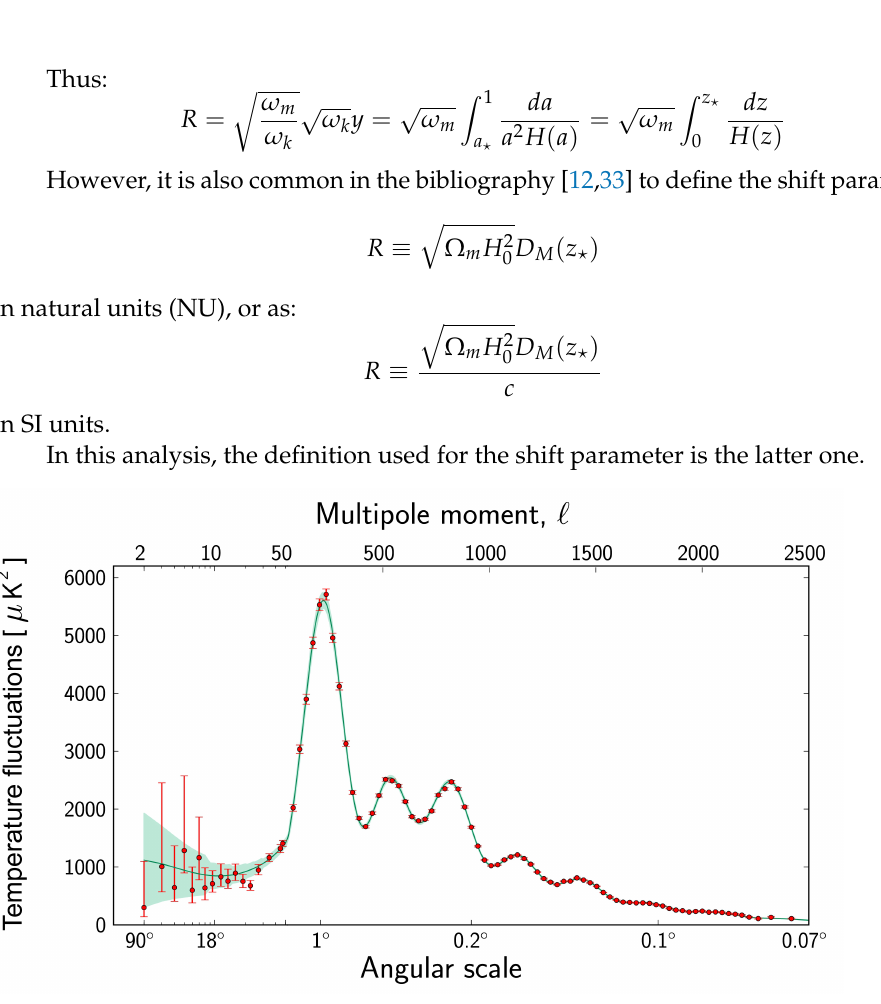
Figure 10. The CMB power spectrum versus the multipole moment l and the angular size θ . The curve shows the theoretical prediction of the power spectrum, while the red points represent the Planck data as of March 2013. Adapted from: